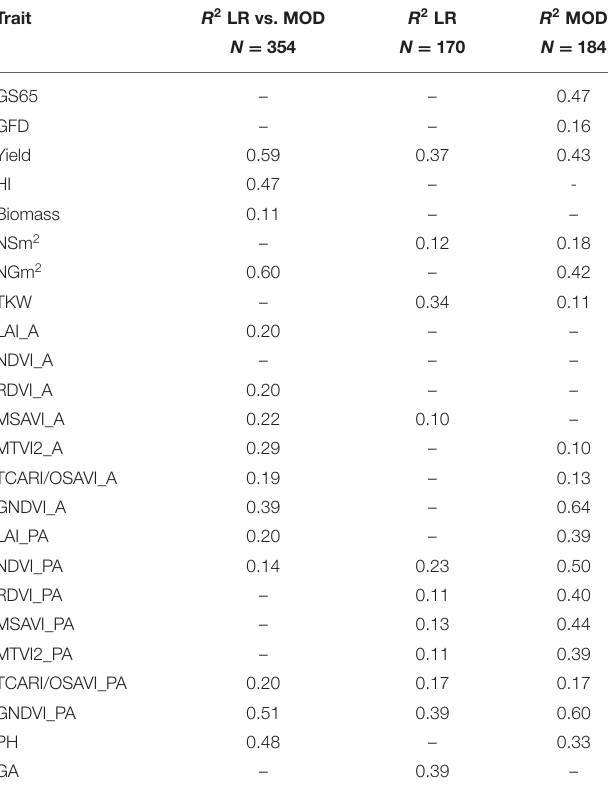
TABLE 7 | Relationship between trait variation and population structure ( q -values) for landrace and modern sets separately and the combined set. Trait R 2 LR vs.